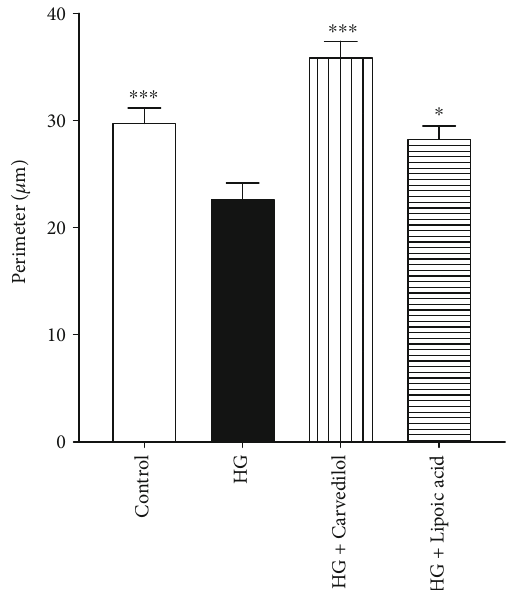
Figure 6: E ff ect of the carvedilol on soma perimeter in high-glucose media.